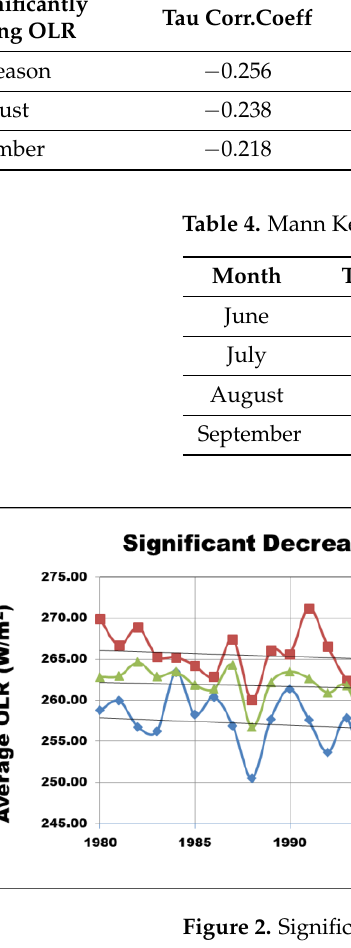
Figure 2. Significant decreasing trend of OLR for ITCZ.